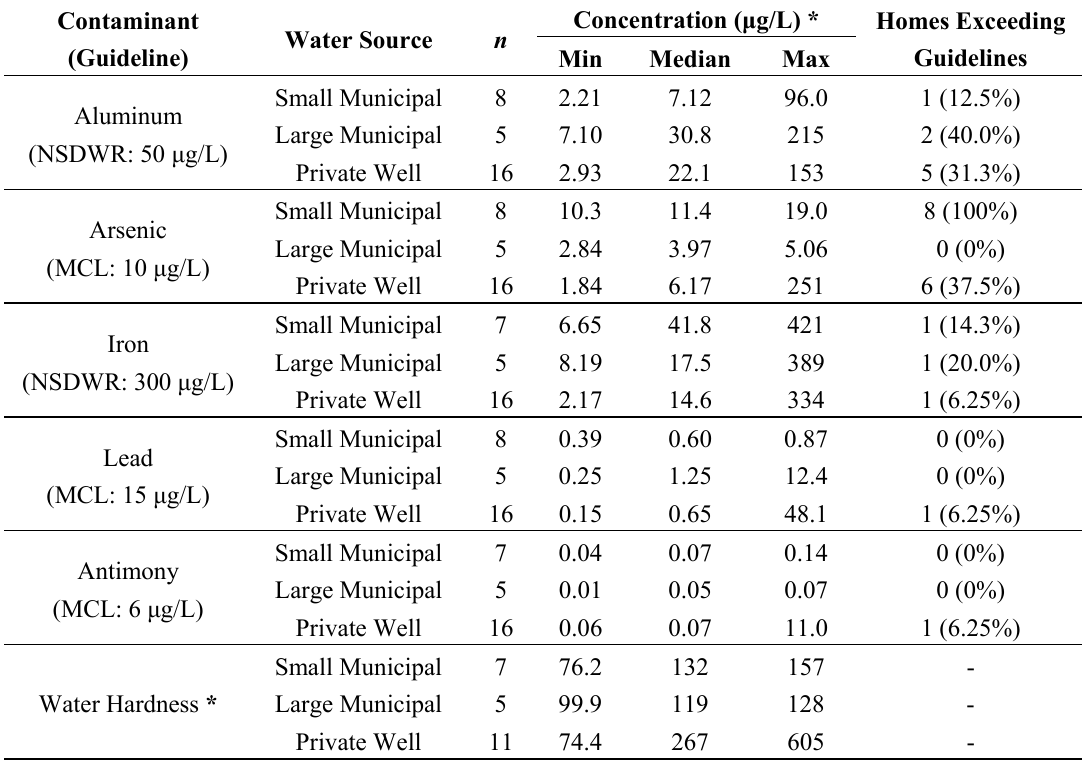
Table 4. Contaminant and water hardness concentrations in untreated water by source and number of homes exceeding either United States Environmental Protection Agency (USEPA) Maximum Contaminant Level (MCL) or National Secondary Drinking Water Regulation (NSDWR) guidelines. Note: Percentages are based on total homes on that water source with a contaminant measurement ( n